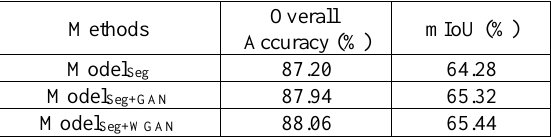
Table 1 . Result on ISPRS Vaihingen test